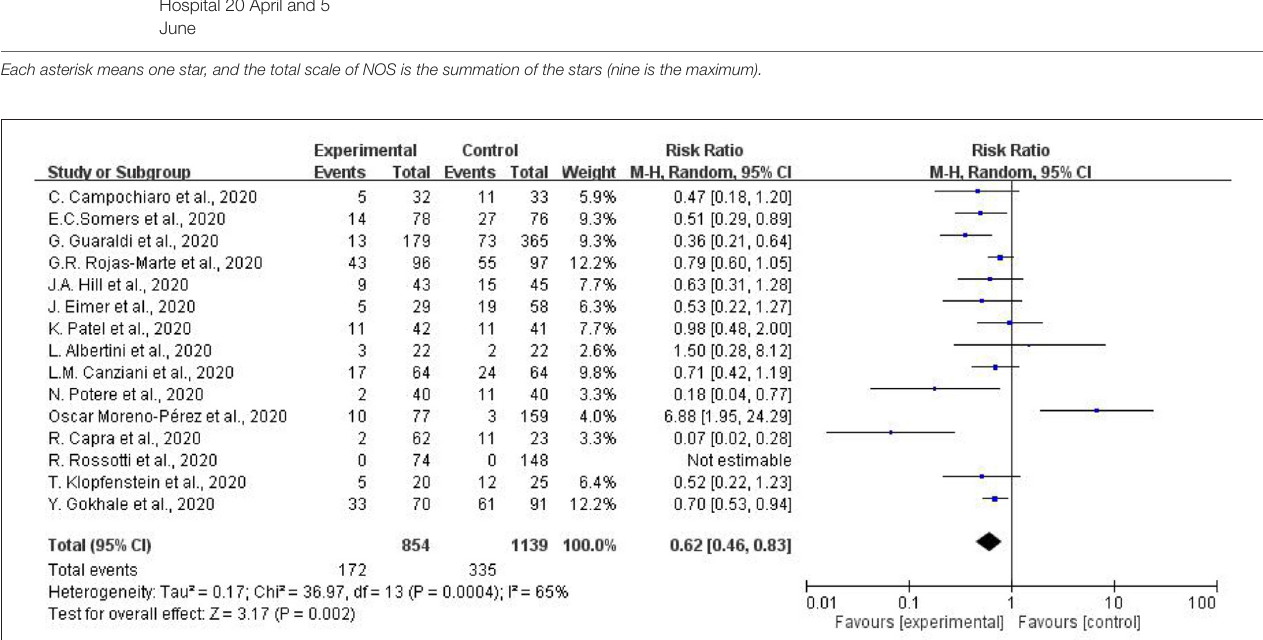
tocilizumab group (14 days) than in the control group (6 days) ( p = 0.001)